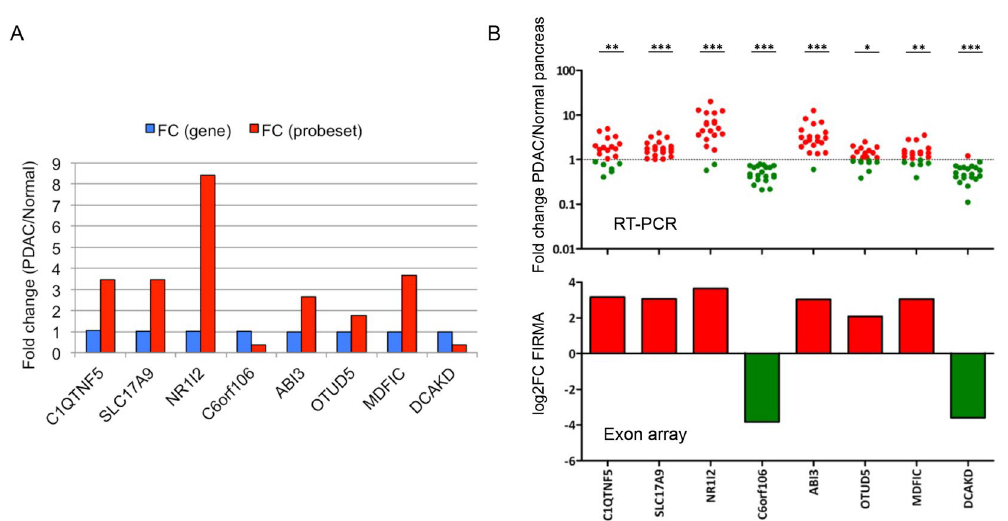
Figure 3. Real-time PCR validation of exon array data. ( A ) Selection of 8 splicing probe-sets from non- differentially expressed genes. For these 8 genes/probe-sets, there were no differences in the level of gene expression, but significant differences in the level of probe-set expression. ( B ) RT-PCR results of the 8 probe- sets. RT-PCR results are represented as scatter dot plots of expression fold change in PDAC compared to normal pancreas, with the significance level shown at the top ( * < 0.05, ** < 0.01, *** < 0.001). Corresponding exon array results are reported in histograms of log 2 FIRMA fold change (PDAC/normal) values. The two sets of results corresponded well with each other very